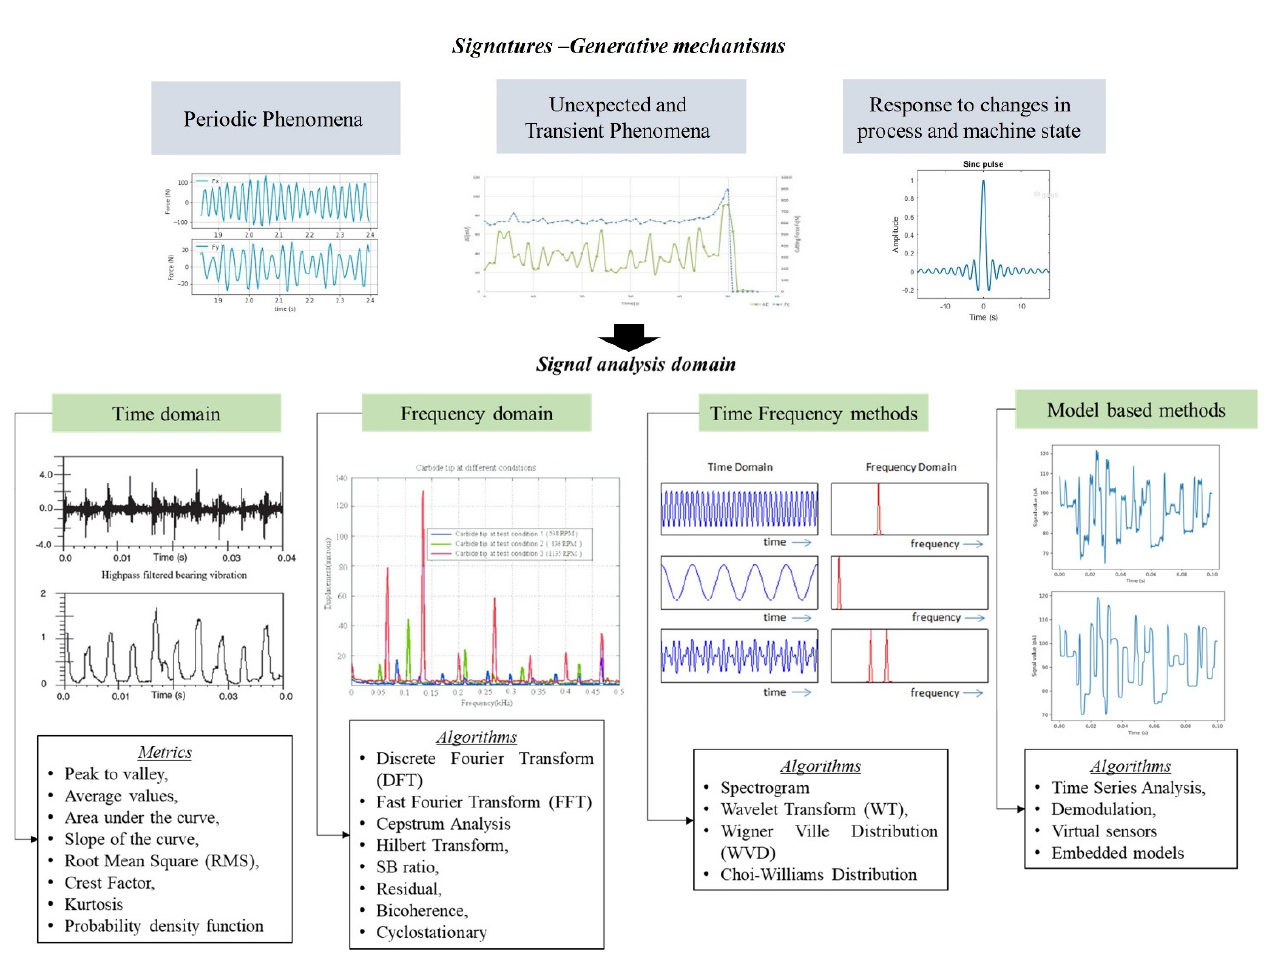
Figure 6. Signal processing techniques and signatures phenomena [68–73].